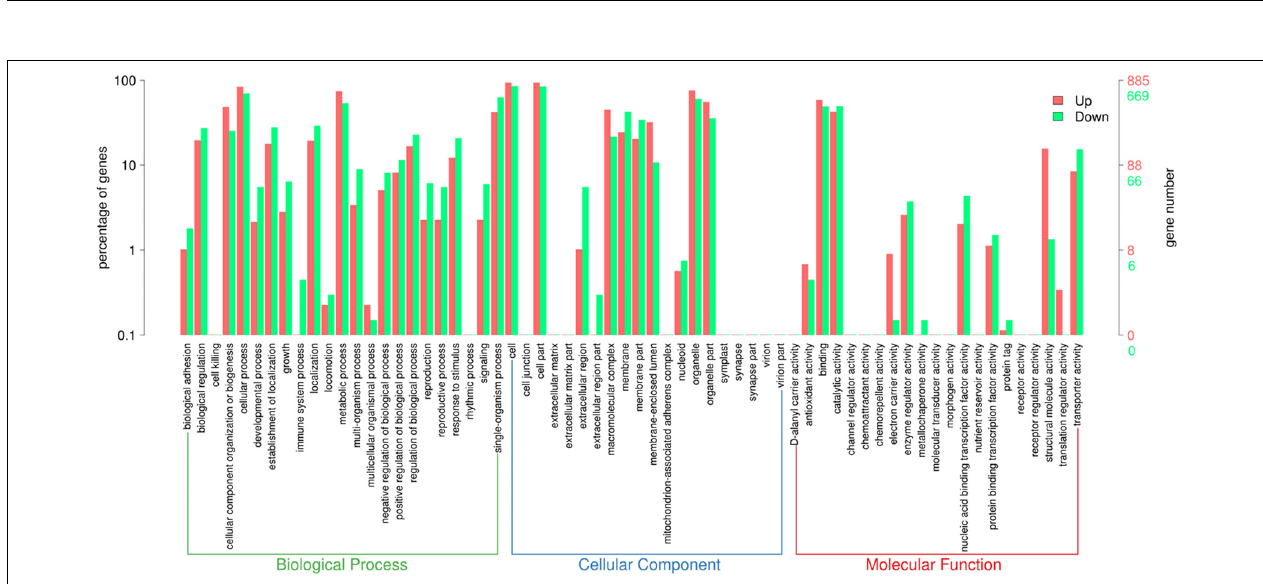
FIGURE 2 | The heatmap of DEGs identified in this study. In the heatmap, rows in red and blue represent upregulated and downregulated genes, respectively. The different depth of colors represents different level of DEG expression.